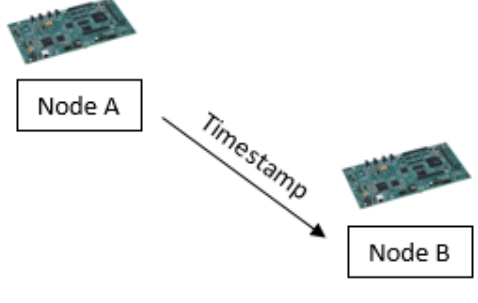
Figure 3. TMDSDSK6713 kits acting as